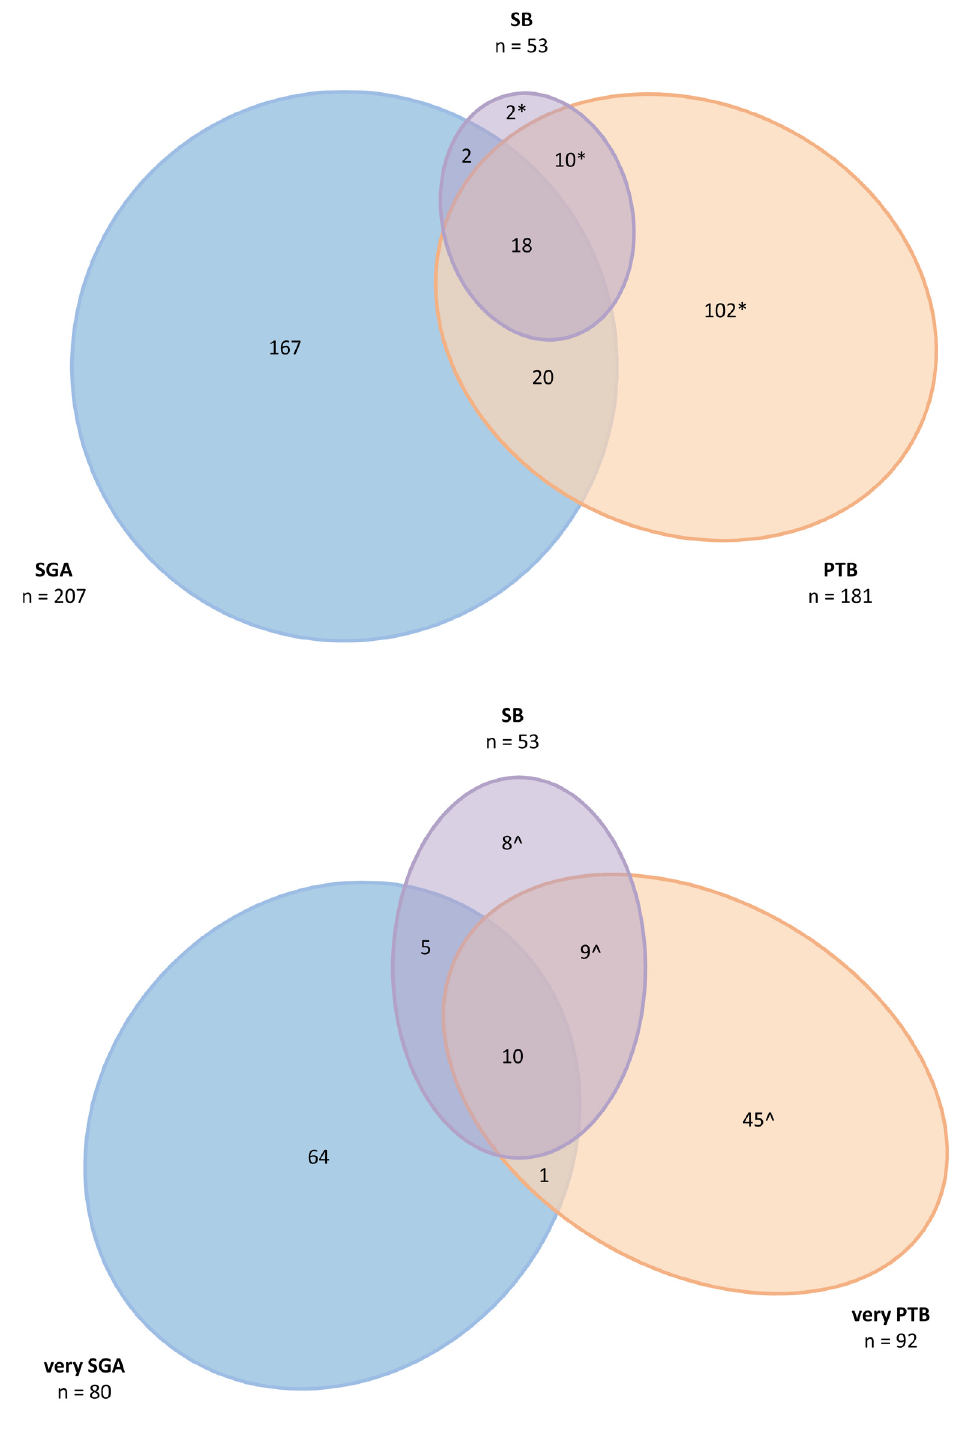
Figure 2. Preterm birth, very preterm birth, small for gestational age, very small for gestational age, and stillbirth among participants retained at delivery in ZAPPS cohort. Among ZAPPS cohort participants retained at delivery, 15% (181/1216) were preterm (PTB), 8% (92/1216) were very PTB, 18% (207/1159) were small for gestational age (SGA), 7% (80/1159) were very SGA, and 4% (53/1209) were stillborn (SB). *11 preterm births (^9 of which were very preterm), one term stillbirth, and 20 preterm stillbirths (^18 of which were very preterm) were either outside the gestational age threshold for INTERGROWTH-21 st calculation of SGA, 28 or were missing birthweight at delivery. Figures created with: EulerAPE.